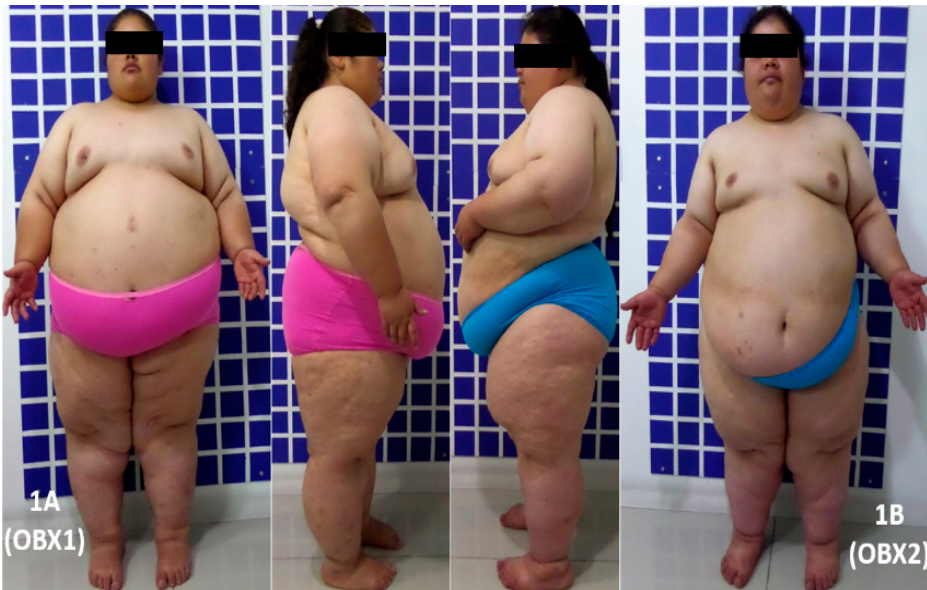
Figure 1. Clinical photographs of two Colombian sisters with congenital leptin deficiency with a newly reported mutation in the leptin gene. OBX1 ( A ) is a 24-year-old female and OBX2 ( B ) is her 21-year-old sister.